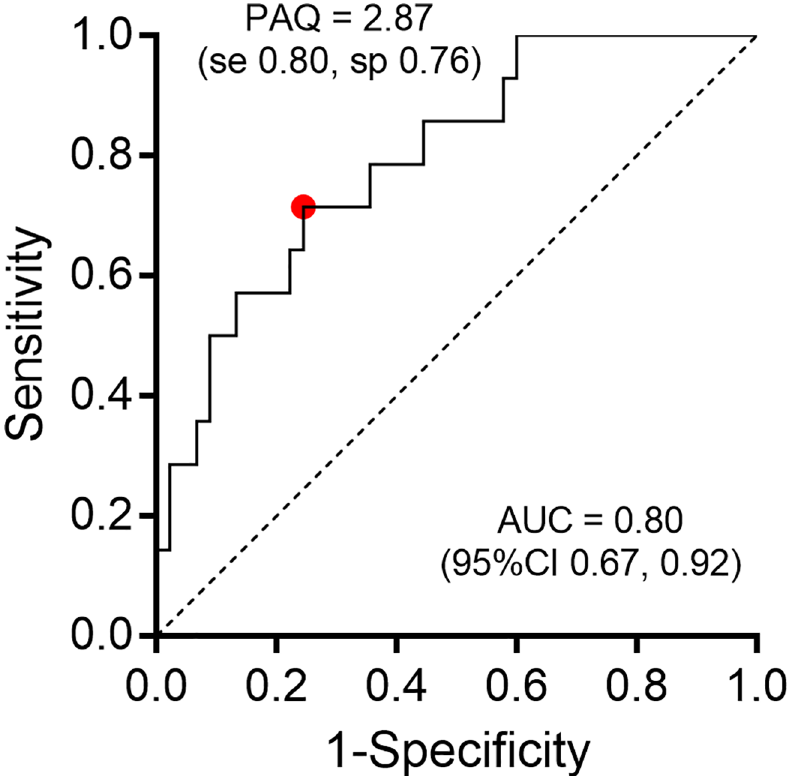
Fig 3. Receiveroperating curve to identify PAQ-score cut-point that descriminates between those who meet physical activity guidelines (defined as (cid:21) 60 min MVPA/d based on accelerometry) versus those that do